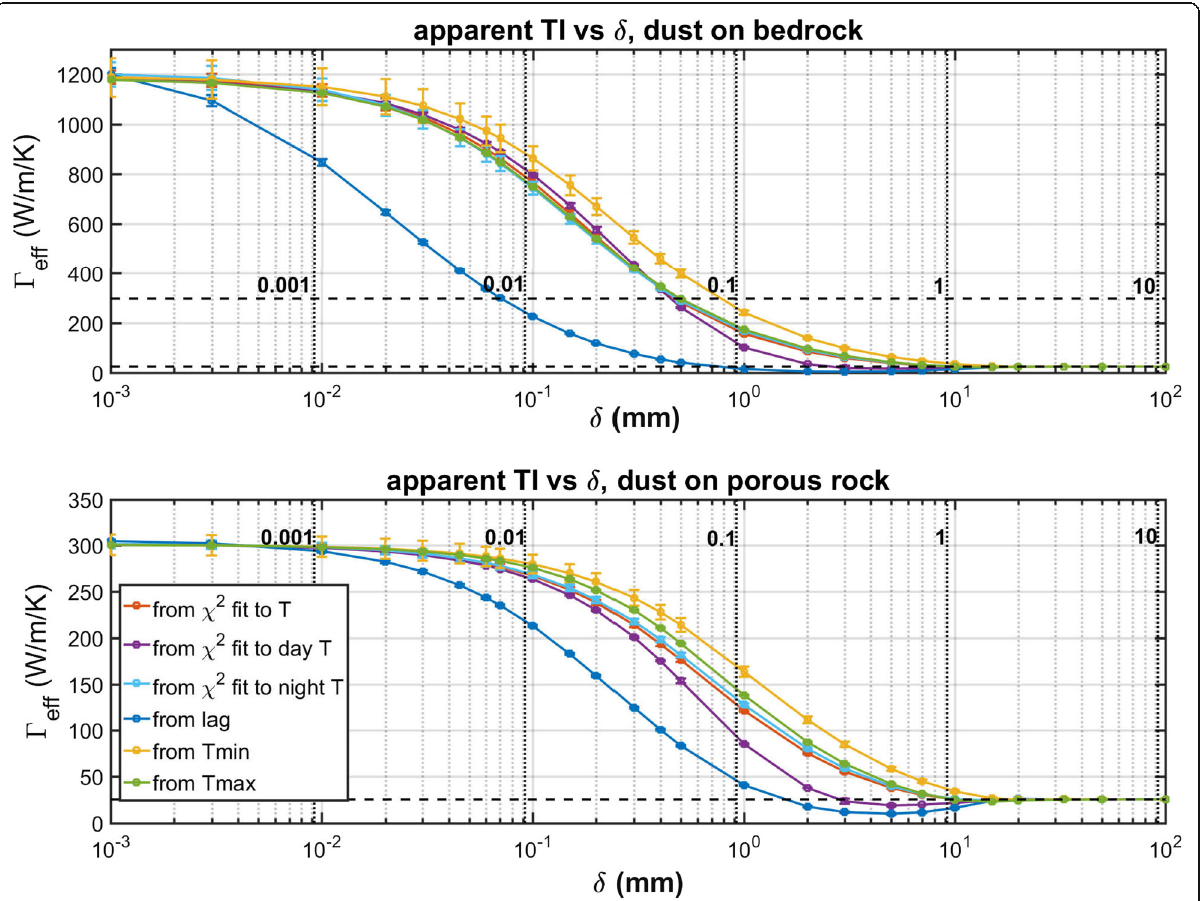
Fig. 4 Top: apparent thermal inertia Γ eff as a function of dust cover layer thickness δ for bedrock. Γ eff has been calculated using various methods (see Methods/Experimental). Top and bottom horizontal dashed lines indicate Γ for the homogeneous rock and dust, respectively. Vertical dotted lines indicate dust layer thickness in units of the diurnal thermal skin depth (9.2 mm) of the dust. Data points are connected by straight lines to guide the eye. Error bars represent the effects of worst-case modeling errors as described in the main text. Bottom: same as top, but for dust-covered porous rock/coarse